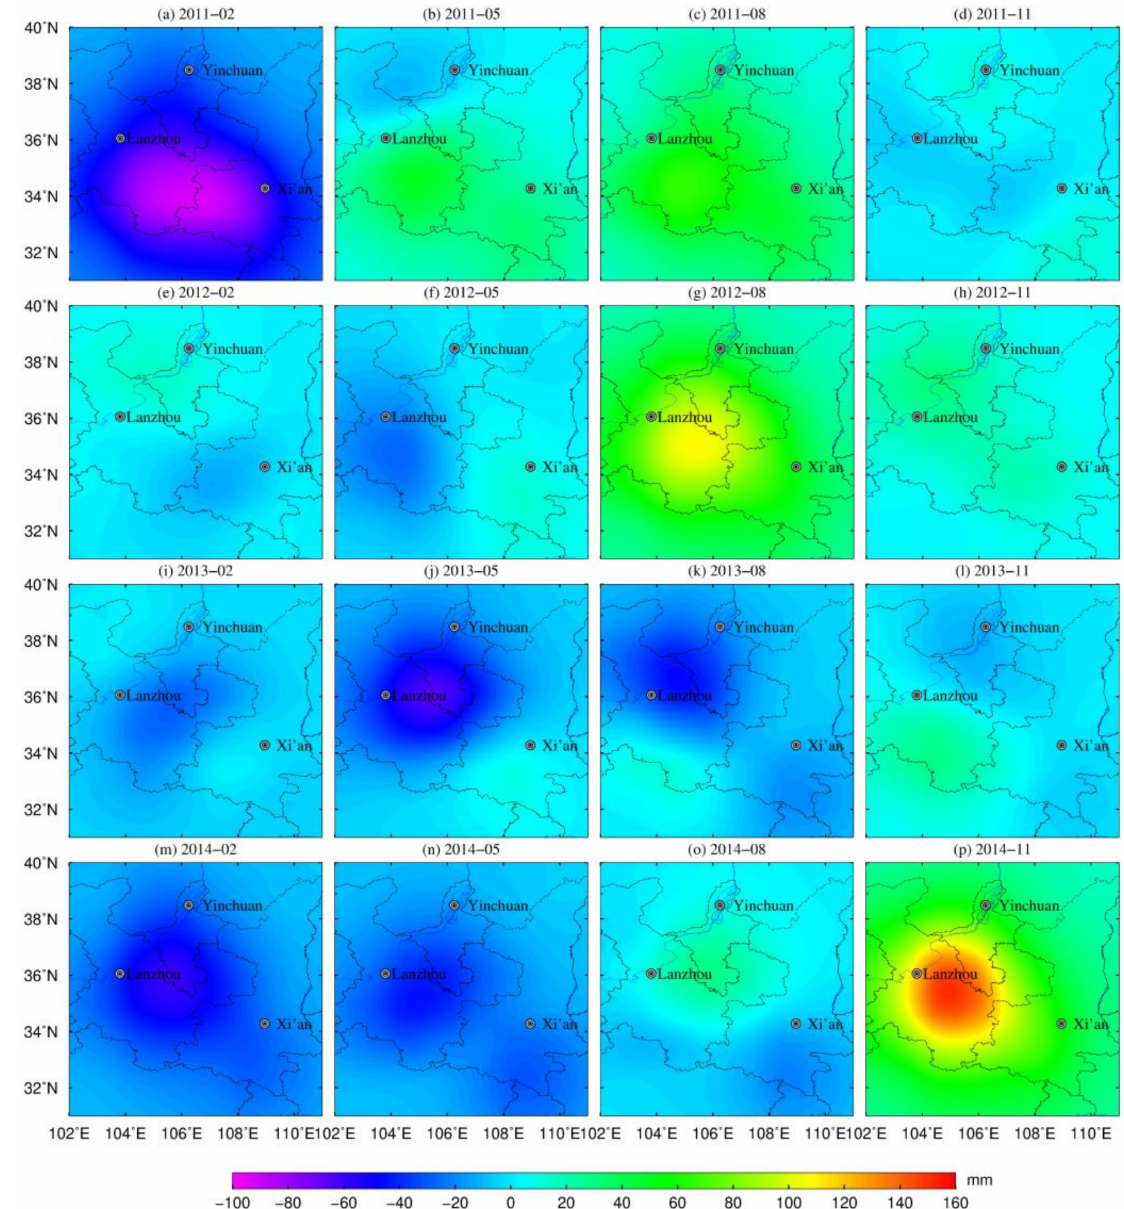
Figure 6. Spatiotemporal variation in GWS in the SGN region from 2011 to 2014 derived from GNSS